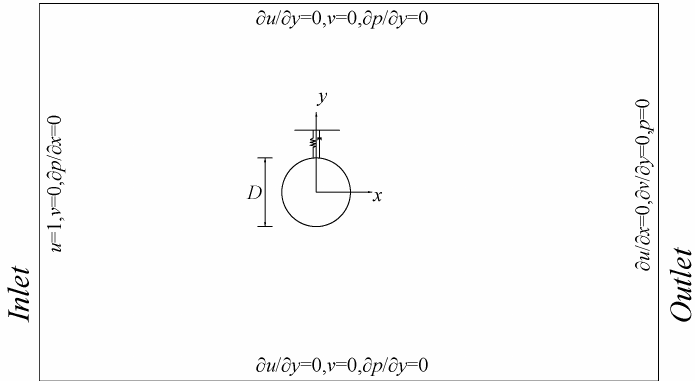
Figure 2. Sketch definition of computational domain and boundary conditions.